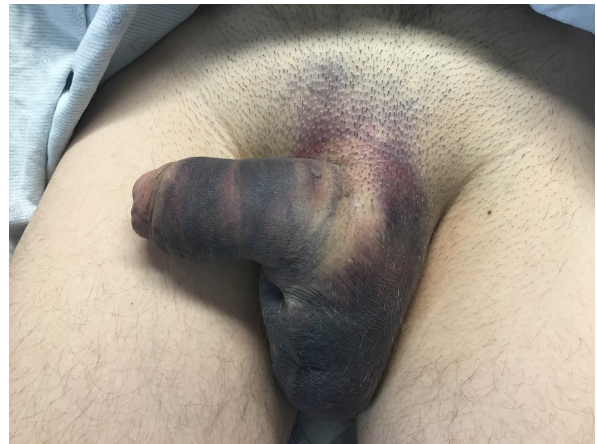
Fig. 1. Clinical Presentation of Patient with Penile Fracture. Adapted from Ory et al . [15]. Copyright CUA. Reprinted with permission. Swelling and ecchymoses of the shaft is referred to as “eggplant